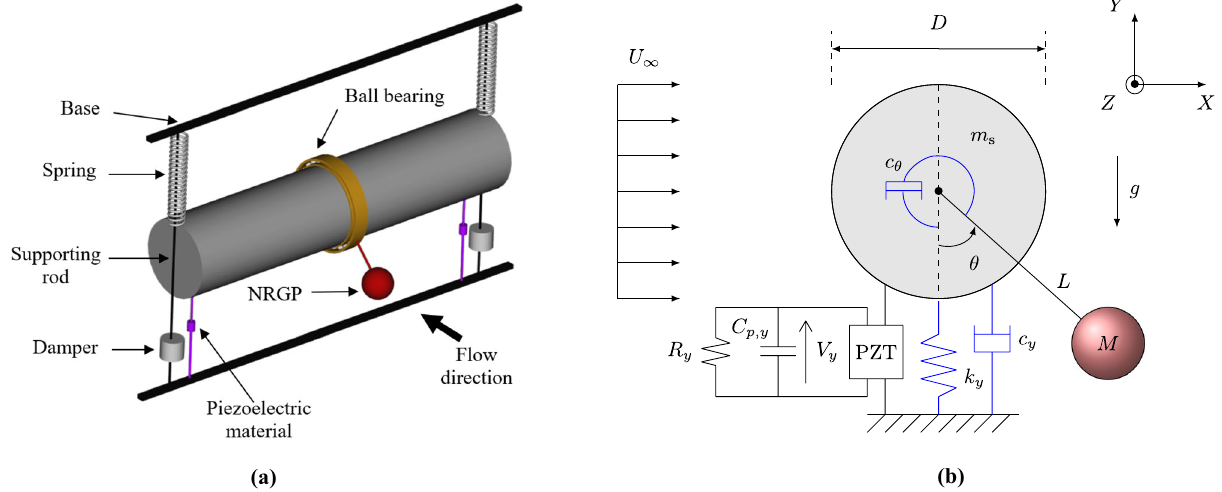
Figure 1. A VIV-based energy extraction device with the NRG pendulum. ( a ) 3-D illustration of the conceptual model, and ( b ) Schematic